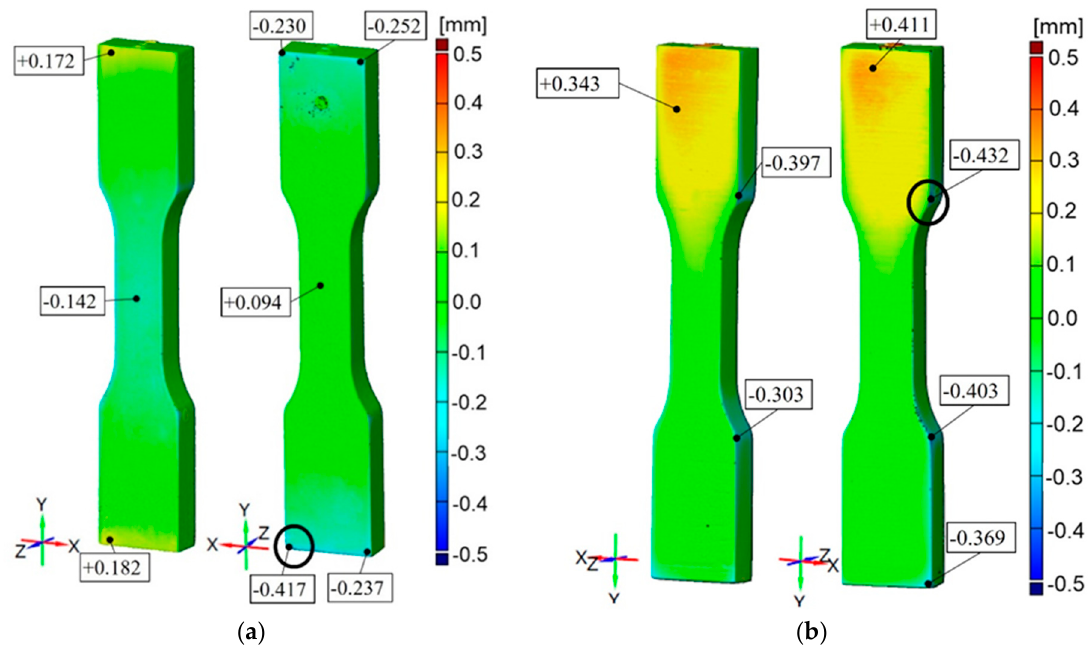
Figure 10. Geometric accuracy [mm] for the specimens made of ABS Ivory GEN 2 material and printed with nominal layer thickness 0.03 mm: ( a ) Raster orientation: horizontal (X-axis), specimen ID: 2; ( b ): Raster orientation: vertical (Z-axis), specimen ID: 5.